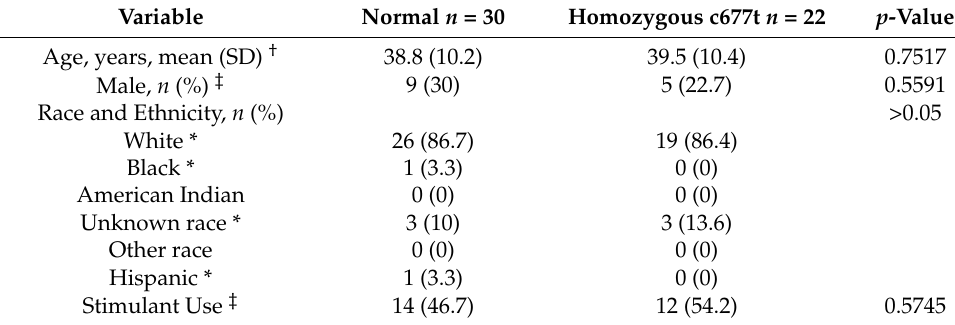
Table 2. Homozygous C677T compared to normal MTHFR allele.